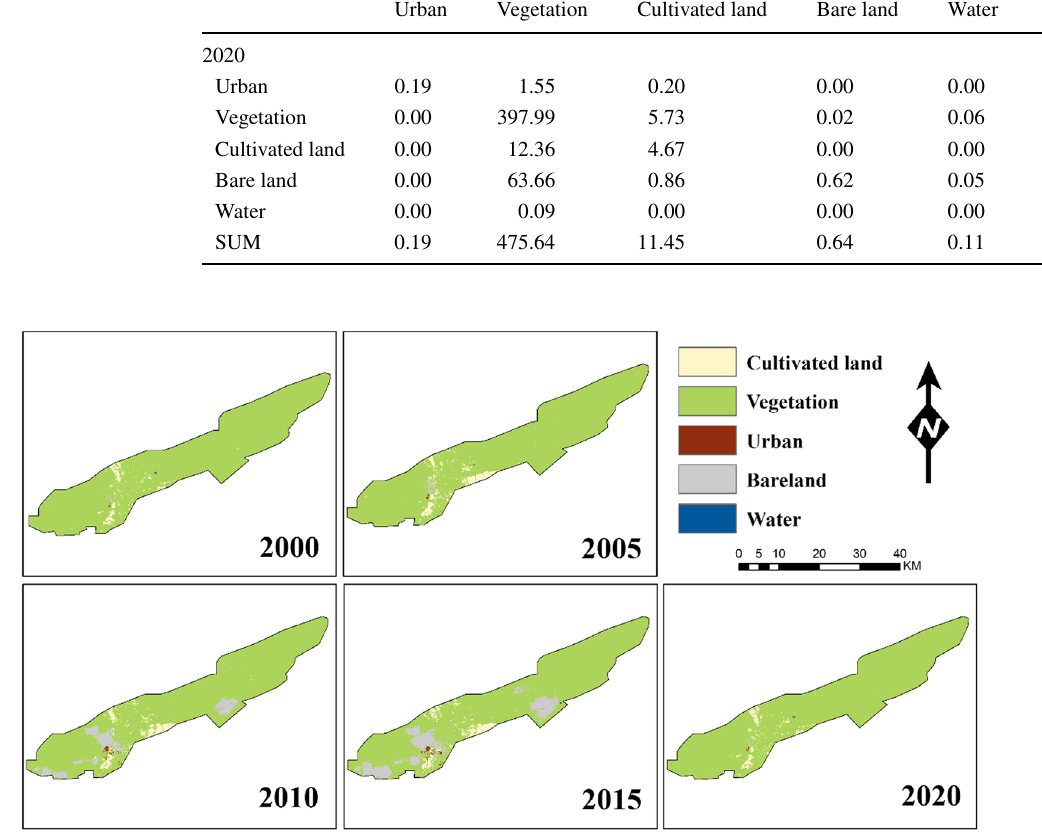
Fig. 5 Maps showing changes in LUCC from 2000 to